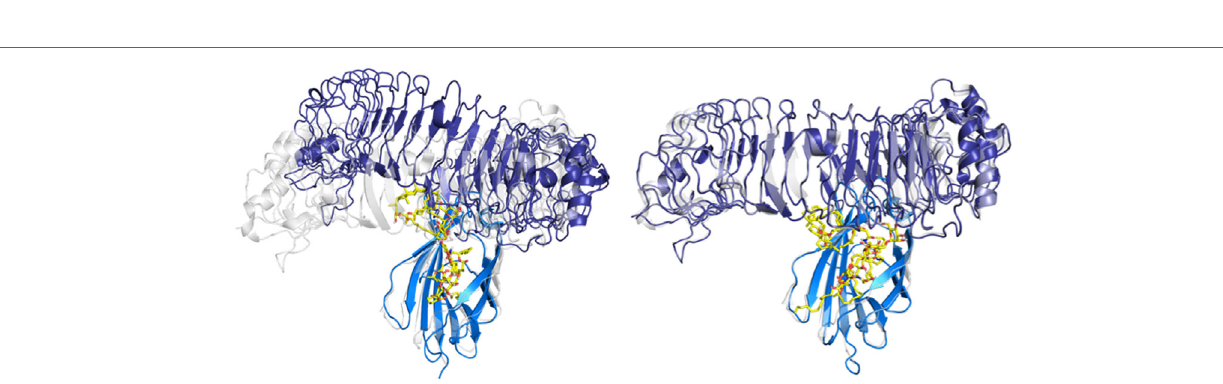
FigUre 8 | Evolution of the myeloid differentiation protein-2 (MD-2)/toll-like receptor 4 (TLR4)/HOPA complex (blue/violet/yellow) over the MD simulation. MD-2/ TLR4 structure from PDB ID 3FXI, represented in semi-transparent cartoon (gray), was superimposed for comparison purposes. On the left: system at t = 0 ns, from the docking calculation. On the right: system at t = 100 ns of MD simulation.